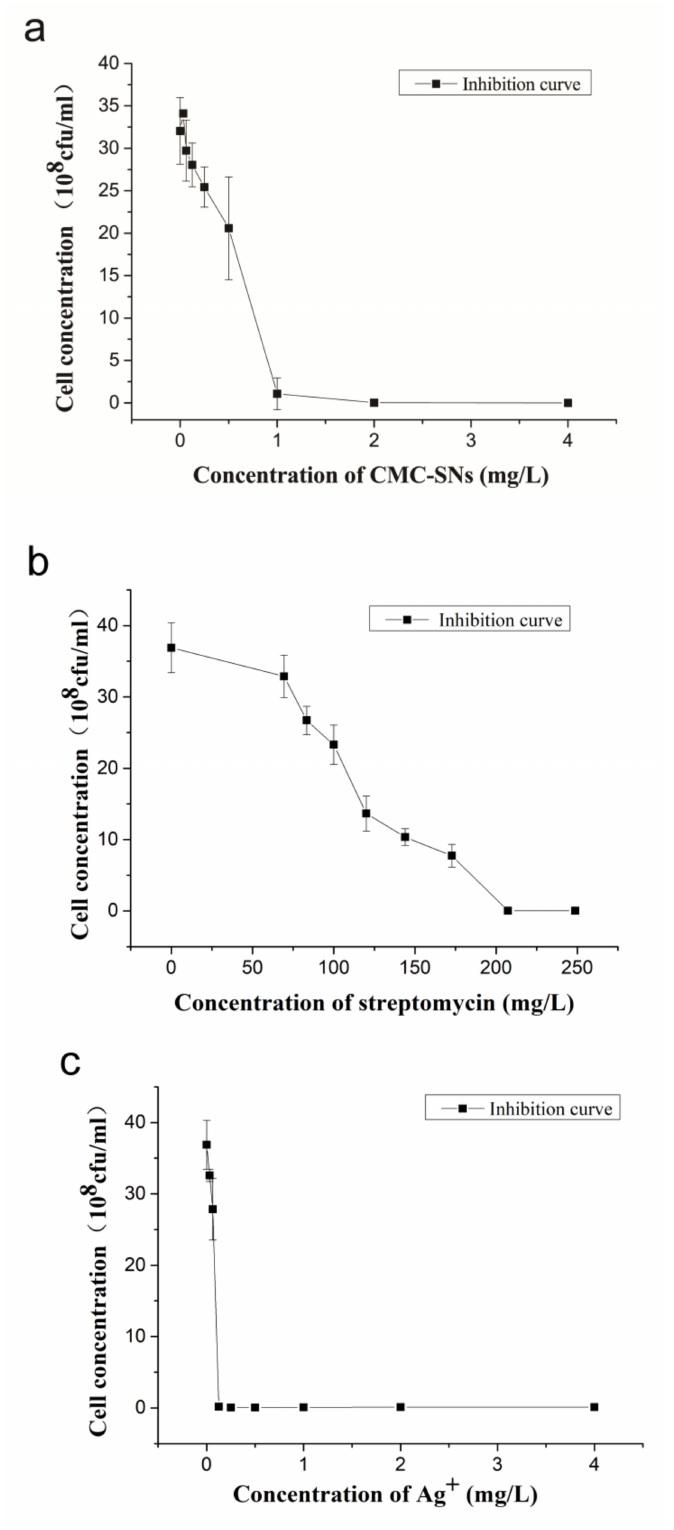
Figure 6. Bacterial cell concentration after 12 h of di ff erent treatments. ( a ) Treated with CMC-SNs; ( b ) treated with streptomycin; ( c ) treated with silver